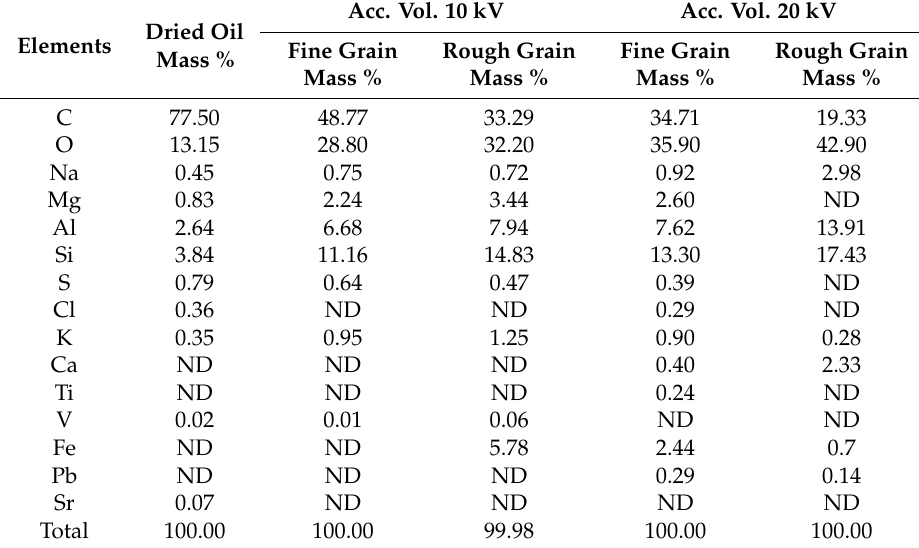
Table 1. Scanning electron microscopy and energy dispersive analyses of oil and soils on the rope collected from the Atake seashore, showing an abundance of C, O, Al, Si, and Fe. (SEM-EDS system; no coating samples, acc. vol. 10 kV and 20